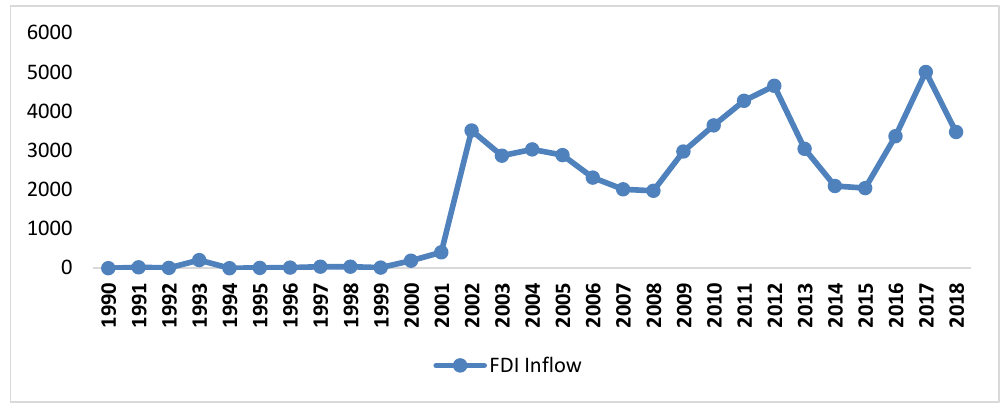
Fig. 1. Iran’s FDI inflow during the period of